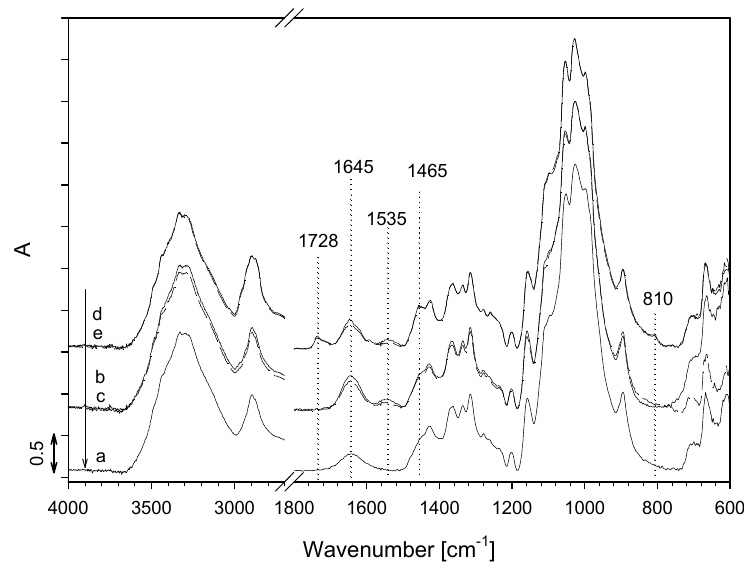
Figure 7. IR ATR spectra of the studied cotton-cellulose samples: CO_UN ( a ), CO_M1 ( b ), CO_M2 ( c ), CO_M1+S ( d ) and CO_M2+S ( e ).